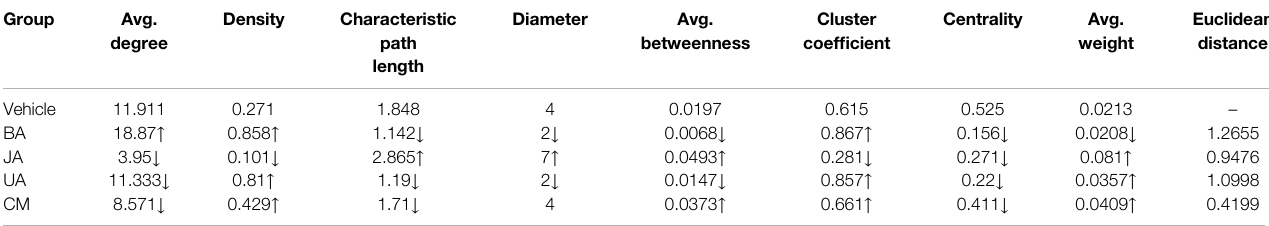
TABLE 1 | Topological parameters of the module map in different groups. The symbols “ ↑ ” and “ ↓ ” represent “ increase ” and “ decrease, ” respectively, compared with the vehicle group. The three highlighted parameters with red letter were selected as the representative index of the three types of parameters for further euclidean distance